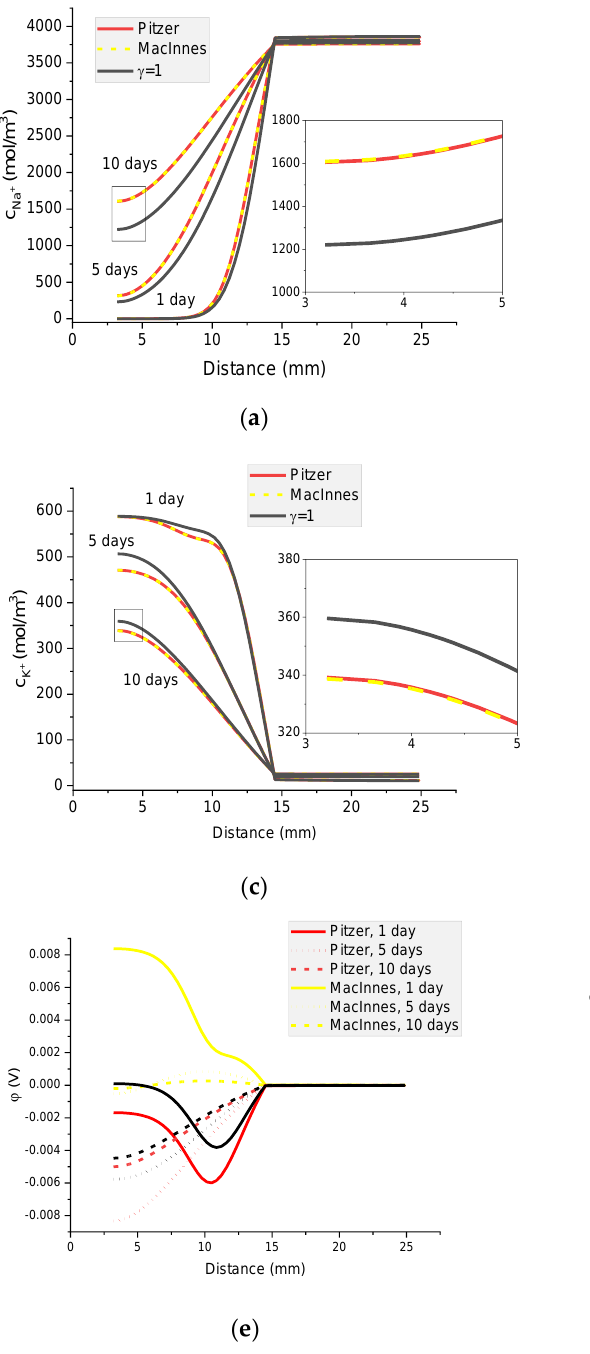
Figure 17. Calculated concentration profiles of ions in the mortar immersed in 20 wt% NaCl water solution. ( a ) Na + ; ( b ) Cl − Cl − ; ( c ) K + ; ( d ) OH − ; electrical potential ( e ) and ionic strength ( f ). Pitzer model (red), MacInnes (yellow), ideal solution ( γ = 1) (black) after 1, 5, and 10 days.